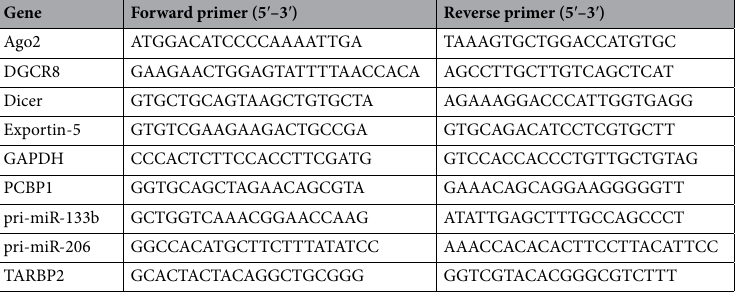
Table 1. Sequences of primers used for